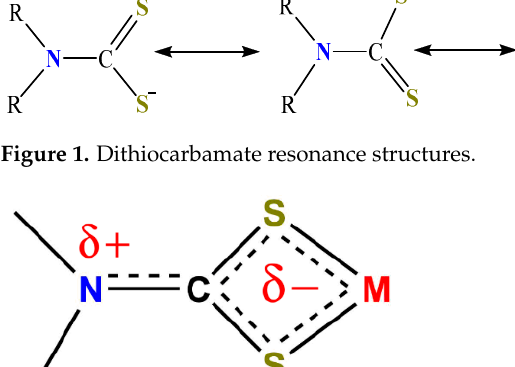
Figure 1. Dithiocarbamate resonance structures.